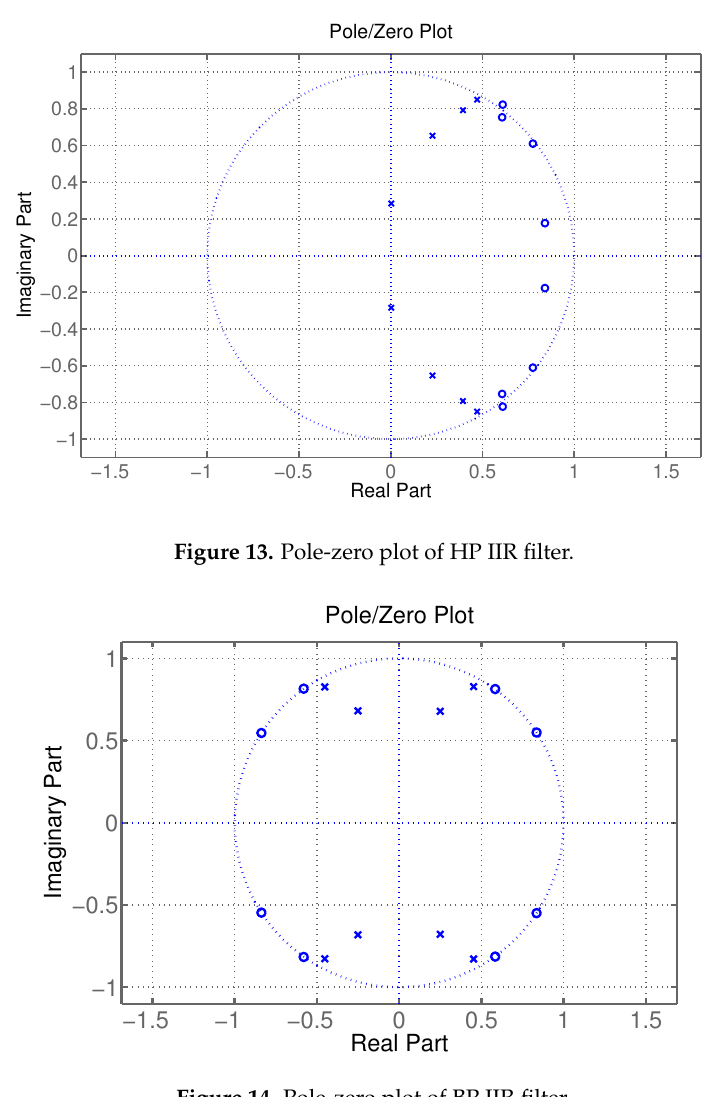
Figure 14. Pole-zero plot of BP IIR filter.